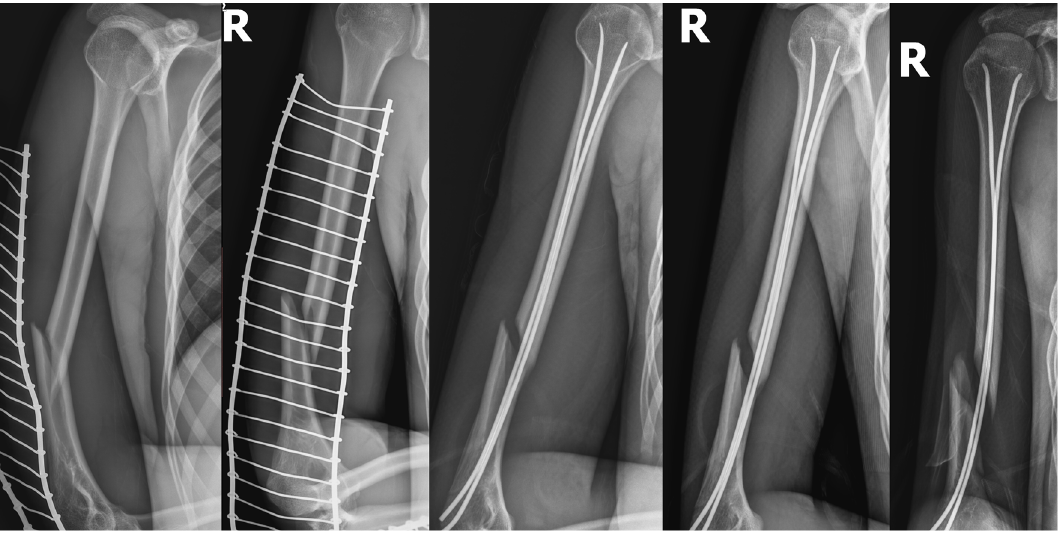
Figure 1. Patient No. 6. post-traumatic X-rays; subsequent control X-rays after close reduction and internal fixation/flexible intramedullary nailing (CRIF/FIN) showing increasing displacement of the bone fragments.